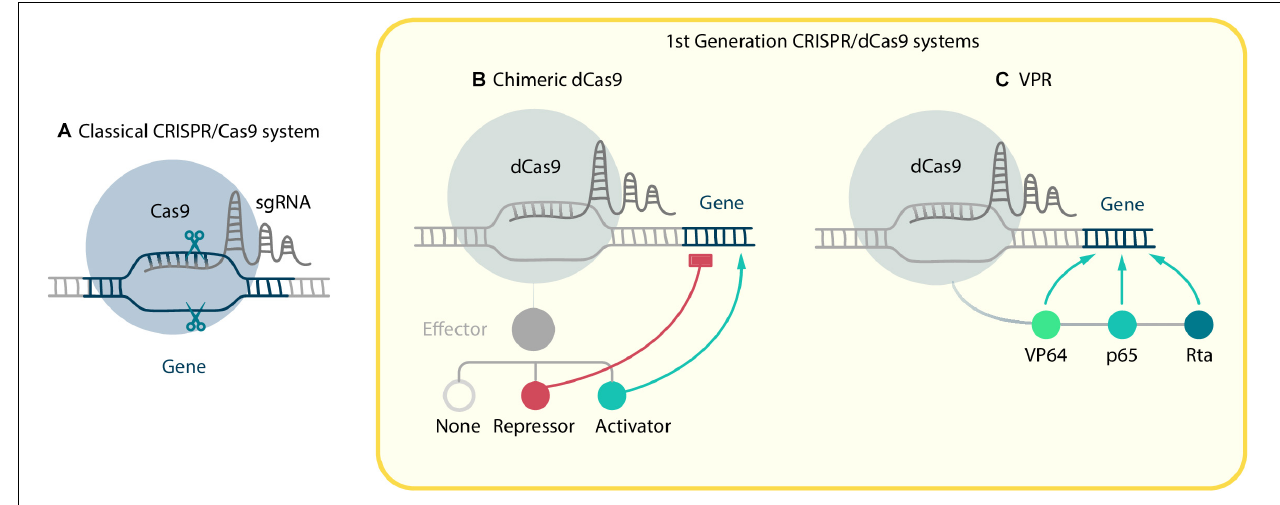
FIGURE 1 | CRISPR/Cas9-based systems. (A) Classical CRISPR/Cas9 system, where sgRNA guided Cas9 performs a double-strand break in target locus. In order to manipulate gene expression the dCas9 mutant without nucleolytic activity was created. First generation CRISPR/dCas9 systems consist of two components: dCas9 fused with effector and sgRNA. They include (B) chimeric dCas9, which can physically block RNA polymerase and repress elongation or, if fused with effectors, activate or repress gene expression; and (C) VPR, where three activator domains VP64, p65, Rta are fused with